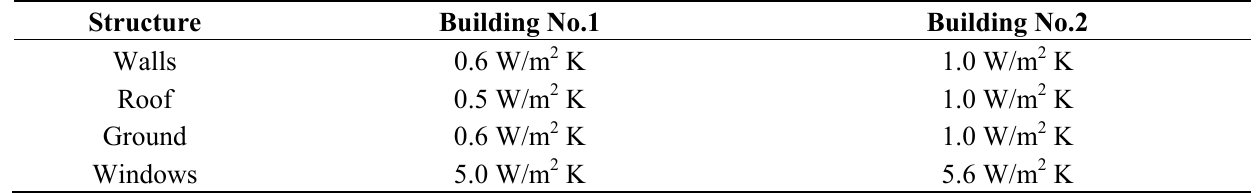
Table 1. Thermal transmittances of the building